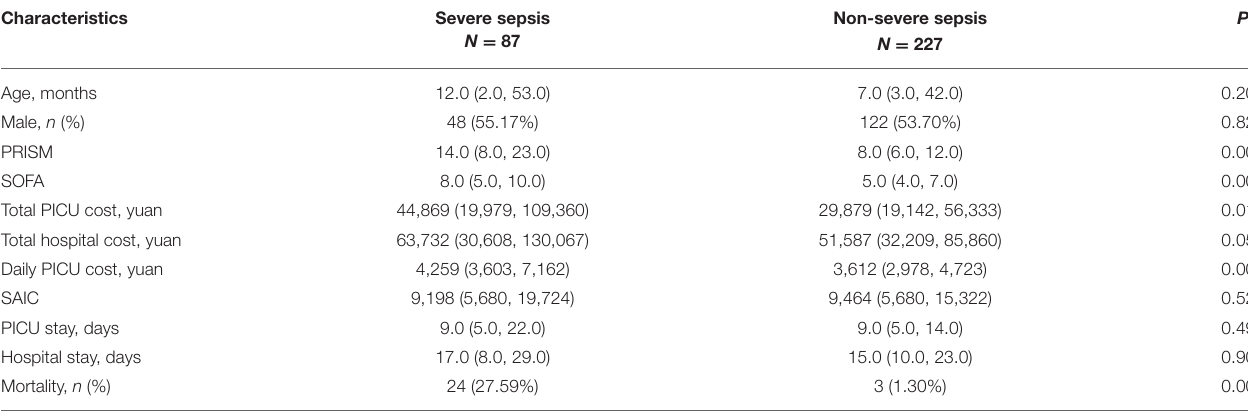
TABLE 4 | Comparison between patients with and without severe sepsis in sepsis-3 definition